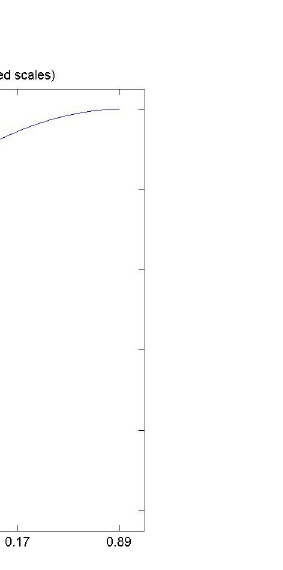
Fig 3. Hypothesis 1,